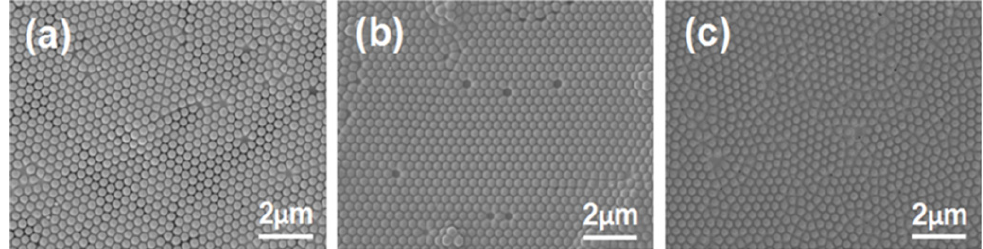
Figure 2. SEM images of polystyrene (PS)/precursor films with different CA/ZA molar ratios: ( a ) 0:1; ( b ) 0.2:1; ( c ) 1:1.